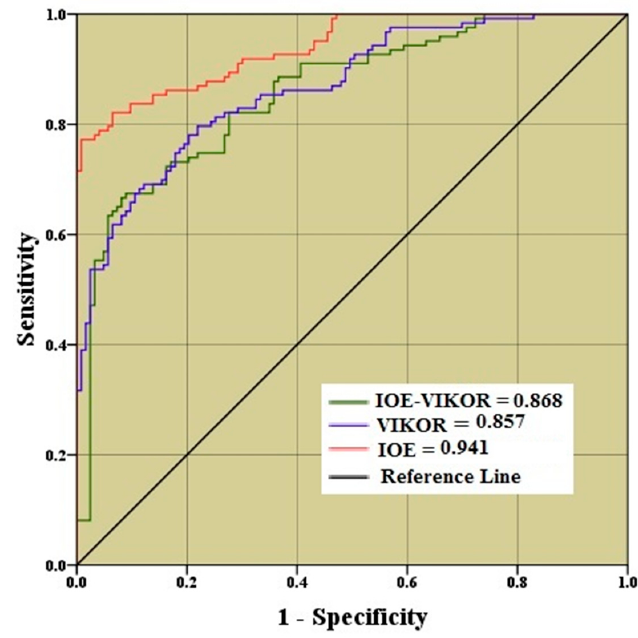
Figure 8. Validation of models.